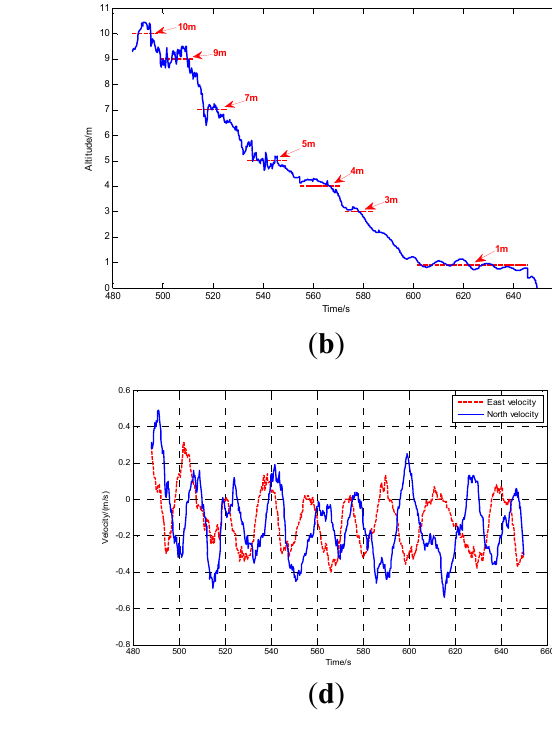
Figure 8. ( a ) The comparison of 3D trajectory of the SUAR with KF and AEKF method in the landing process. ( b ) The altitude trajectory of SUAR in autonomous landing process. ( c ) The pitch and roll angles in autonomous landing process. ( d ) The velocities in two